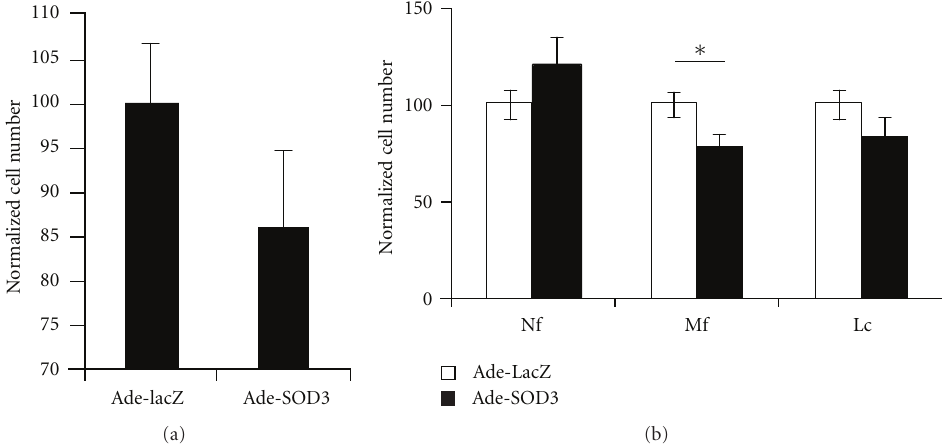
Figure 5: Peritonitis is limited by SOD3 in the absence of functional NOX2 complex. Similarly to wild-type mice, Ade-SOD3-treated Ncf1 ∗ / ∗ mice had less peritoneal infiltrating macrophages than the Ade-LacZ-treated vector controls in the proteose peptone and IL-1 β -induced peritonitis model (a). Normalized total cell numbers (b) show significant decrease in infiltrating macrophage population. Shown is pooled data from two independent experiments ( n = 10) (Nf = neutrophil, Mf = macrophage, Lc = lymphocyte).